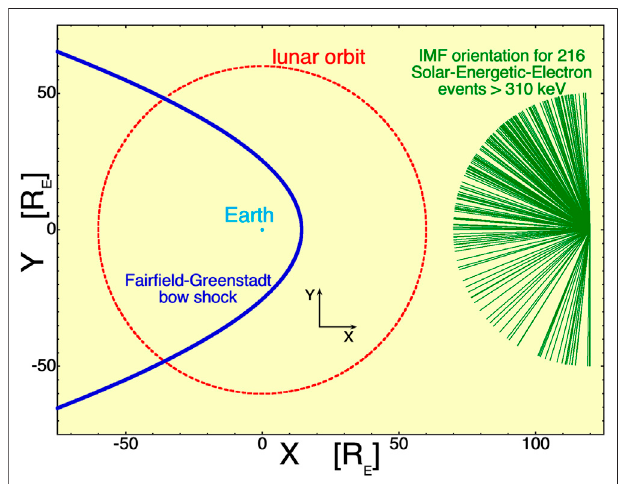
FIGURE 1 | A depiction of the lunar orbit (red dashed) relative to the Earth (light blue) and the Earth ’ s bow shock (blue solid). Indicated in green is the orientation of the solar wind magnetic fi eld at the onsets of 216 strong solar-energetic-electron events. The orientation of the GSE coordinate system is also